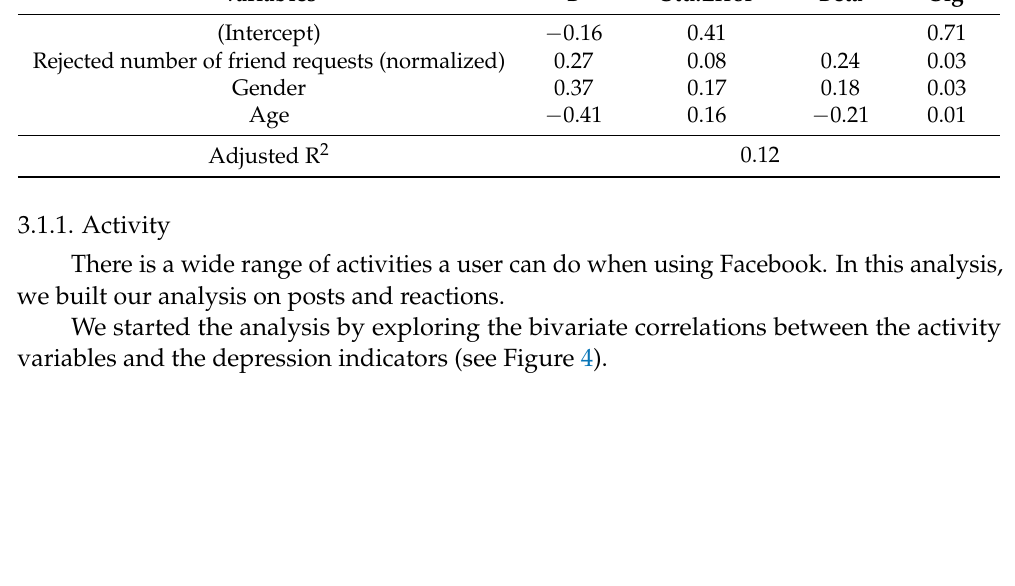
Table 4. Linear Regression model. Dependent variable: somatic depression.